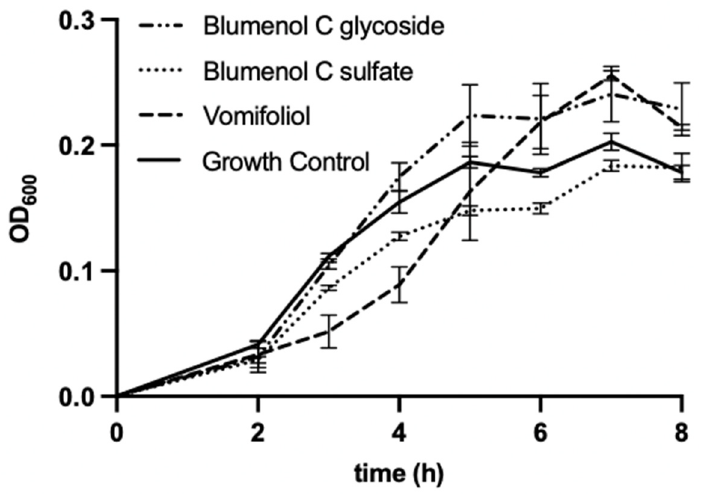
Figure 5. Microdilution assay of blumenol C sulfate ( 1 ), blumenol C glucoside and vomifoliol (=blumenol A), each 200 µg mL − 1 , against B. subtilis . Data shows means of three experiments ± SD.